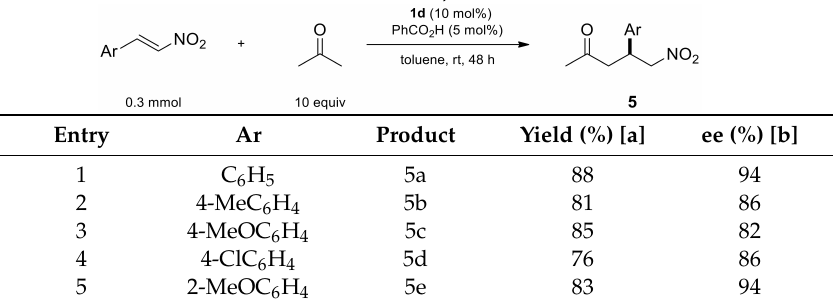
Table 8. Reaction of acetone with α , β -unsaturated